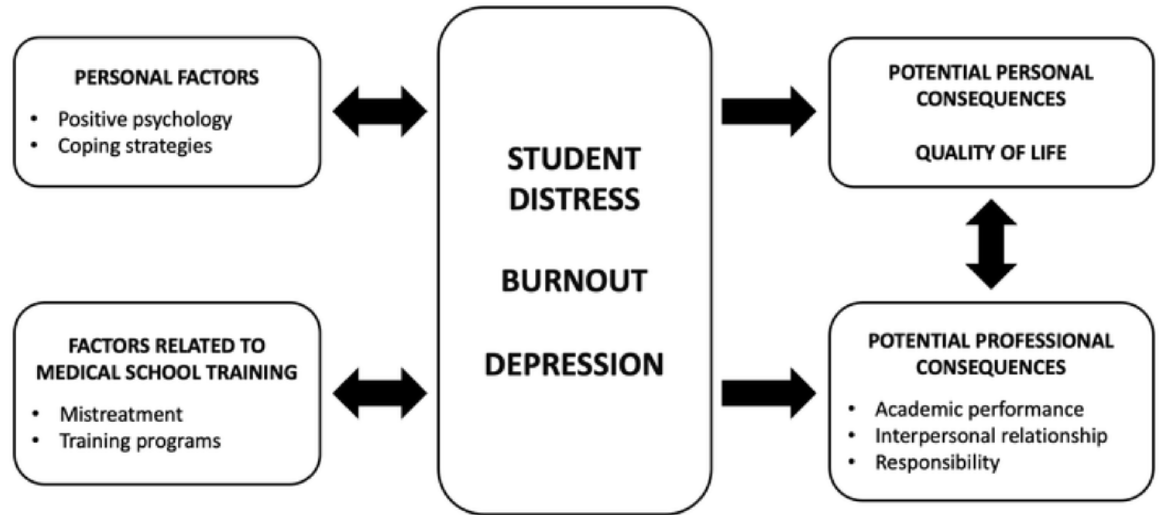
Figure 1. Relationship between student distress, personal factors, potential personal consequences and factors related to medical school training.